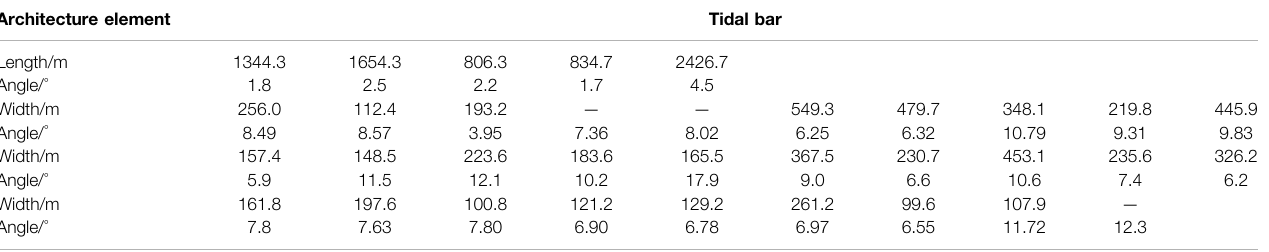
TABLE 3 | The table of tidal bar scale data.